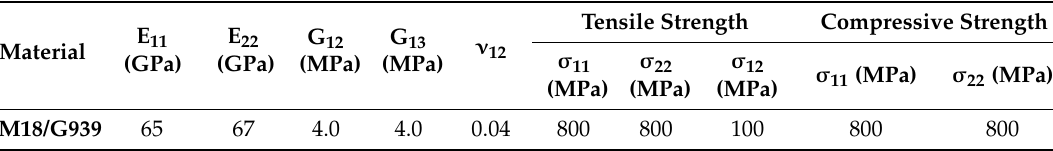
Table 2. Material properties for FM300-2K film adhesive [20].